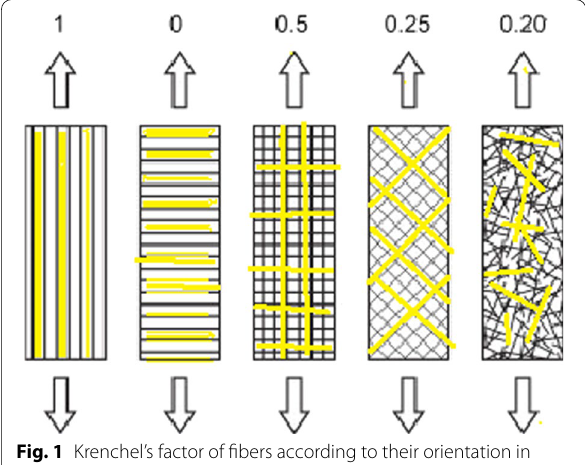
Fig. 1 Krenchel’s factor of fibers according to their orientation in